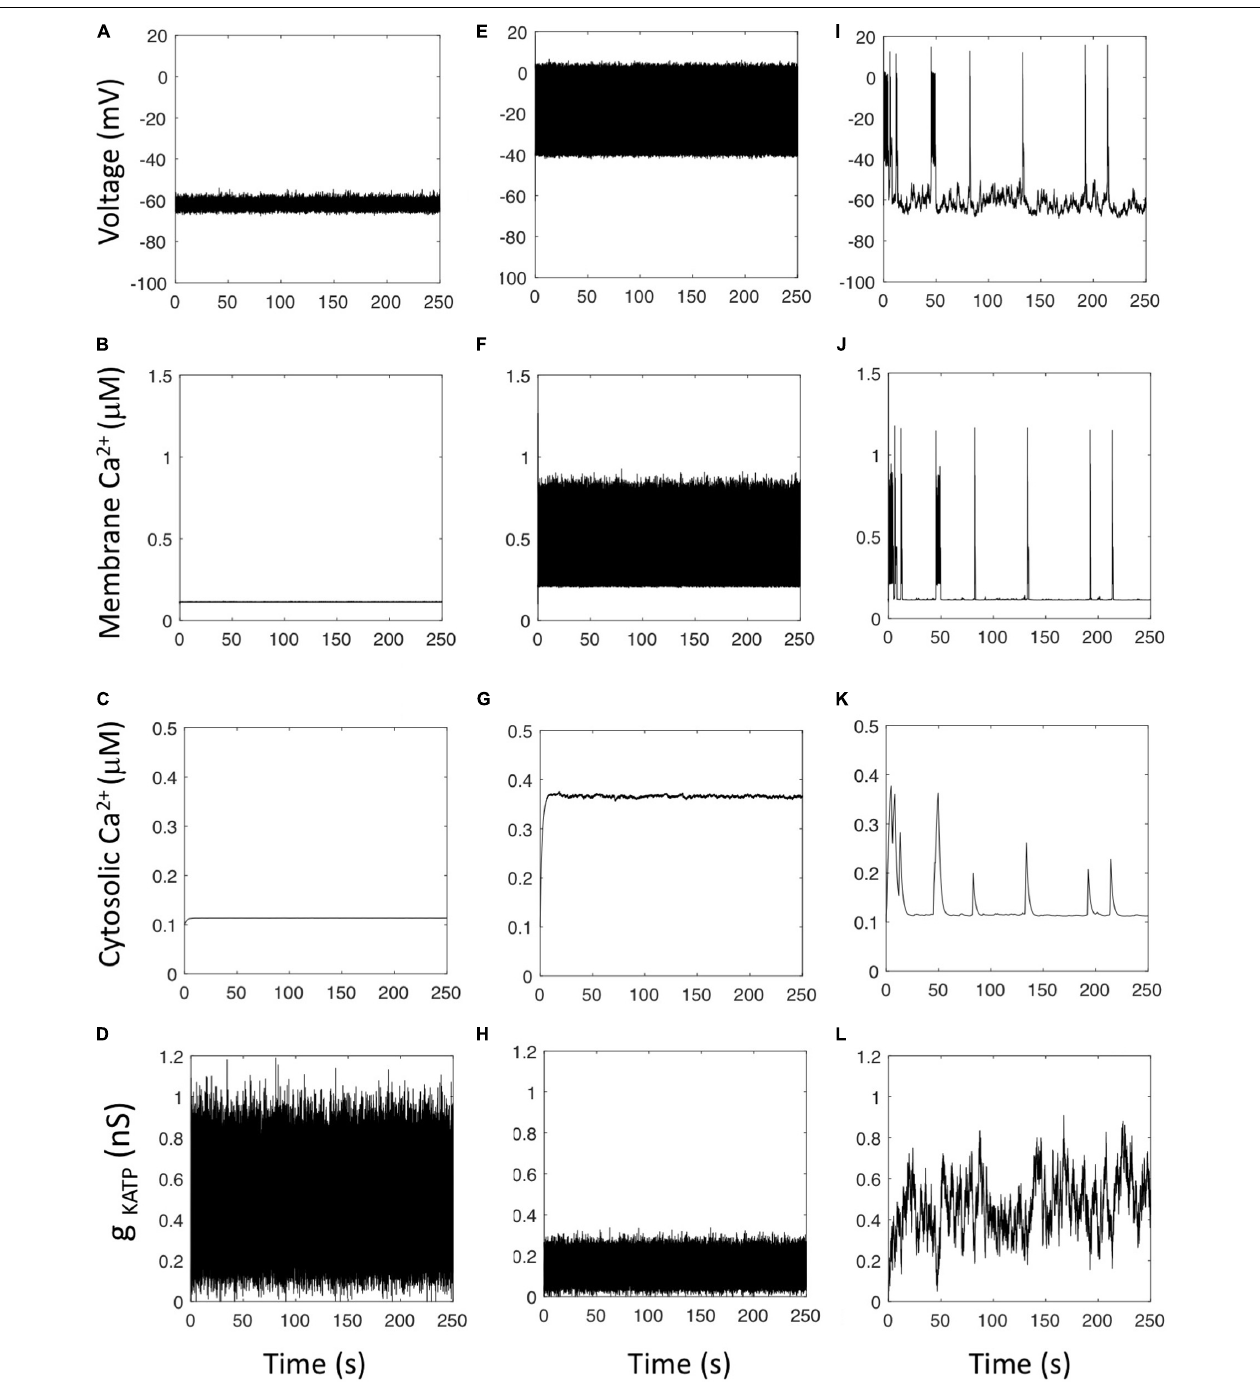
FIGURE 3 | Effect of stochasticity in the K ATP current. Panels show the evolution of the main variables of the model when the conductance of the K ATP channel is described by a Langevin equation (Eqs 7 and 8 with f 2 = 1) to take into account the randomness due to the small number of such channels in α -cells. (A–D) Rate constant of opening of the K ATP channel, α = 0.1 ms − 1 , rate constant of closing of the K ATP channel, β = 0.4 ms − 1 ; unitary conductance of the K ATP channel g s KATP = 0.041 nS. The cell is in a quiet, hyperpolarized state despite the large variations of the total cell g KATP conductance. (E–H) When the unitary conductance of the K ATP channel equals 0.012 nS, the cell is in a depolarized state resulting in a constantly high Ca 2 + concentration. (I–L) When considering slow rates of opening and closing of the K ATP channel, α = 1 10 − 4 ms − 1 and β = 4 10 − 4 ms − 1 , simulations predict the occurrence of intermittent electrical activity leading to irregular Ca 2 + spikes in the cytosol. Equations are those corresponding to Model 3 (see section “Outline of the Modeling Approach”) with the default values of parameters listed in the Supplementary Material , except for the indicated values of g s KATP and g = 0.2 nS. leak